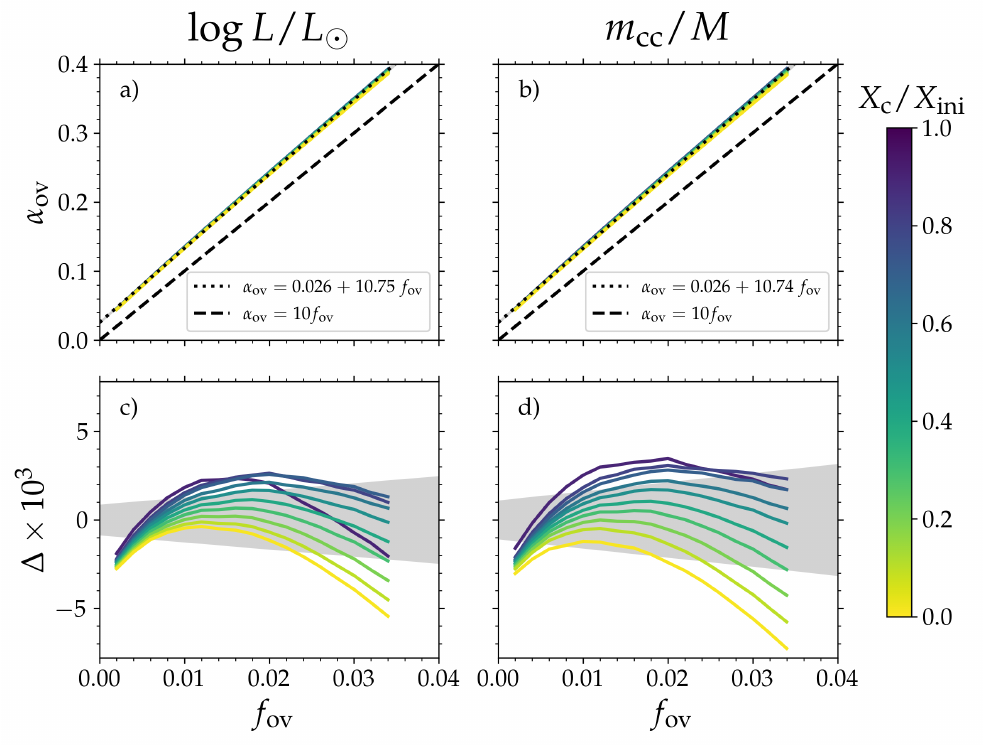
Figure 3. Derived correlations between α ov and f ov for a 10M star at different main-sequence (cid:12) ages given as X c / X ini . ( a ) The colored curves show the relation between α ov and f ov required to obtain log L 1 ( X c / X ini , f ov ) = log L 2 ( X c / X ini , α ov ) . The black dashed curve shows the expected trend assuming α ov = 10 f ov , while the black dotted lines shows the combined linear fit to the colored lines. ( b ) Same as ( a ) but fulfilling m cc ,1 ( X c / X ini , f ov ) / M = m cc ,2 ( X c / X ini , α ov ) / M . ( c ) Differences between the derived α ov versus f ov relation for a given X c / X ini and the linear fit shown by the dotted black line in panel ( a ). The gray shaded region gives the 3 σ std uncertainty region of the linear fit. ( d ) Same as ( c ) but for the comparison between the α ov and f ov parameters needed to obtain the same convective core masses. Figure made by the authors using MESA models. MESA inlists and data used to generate the figure are available on Zenodo